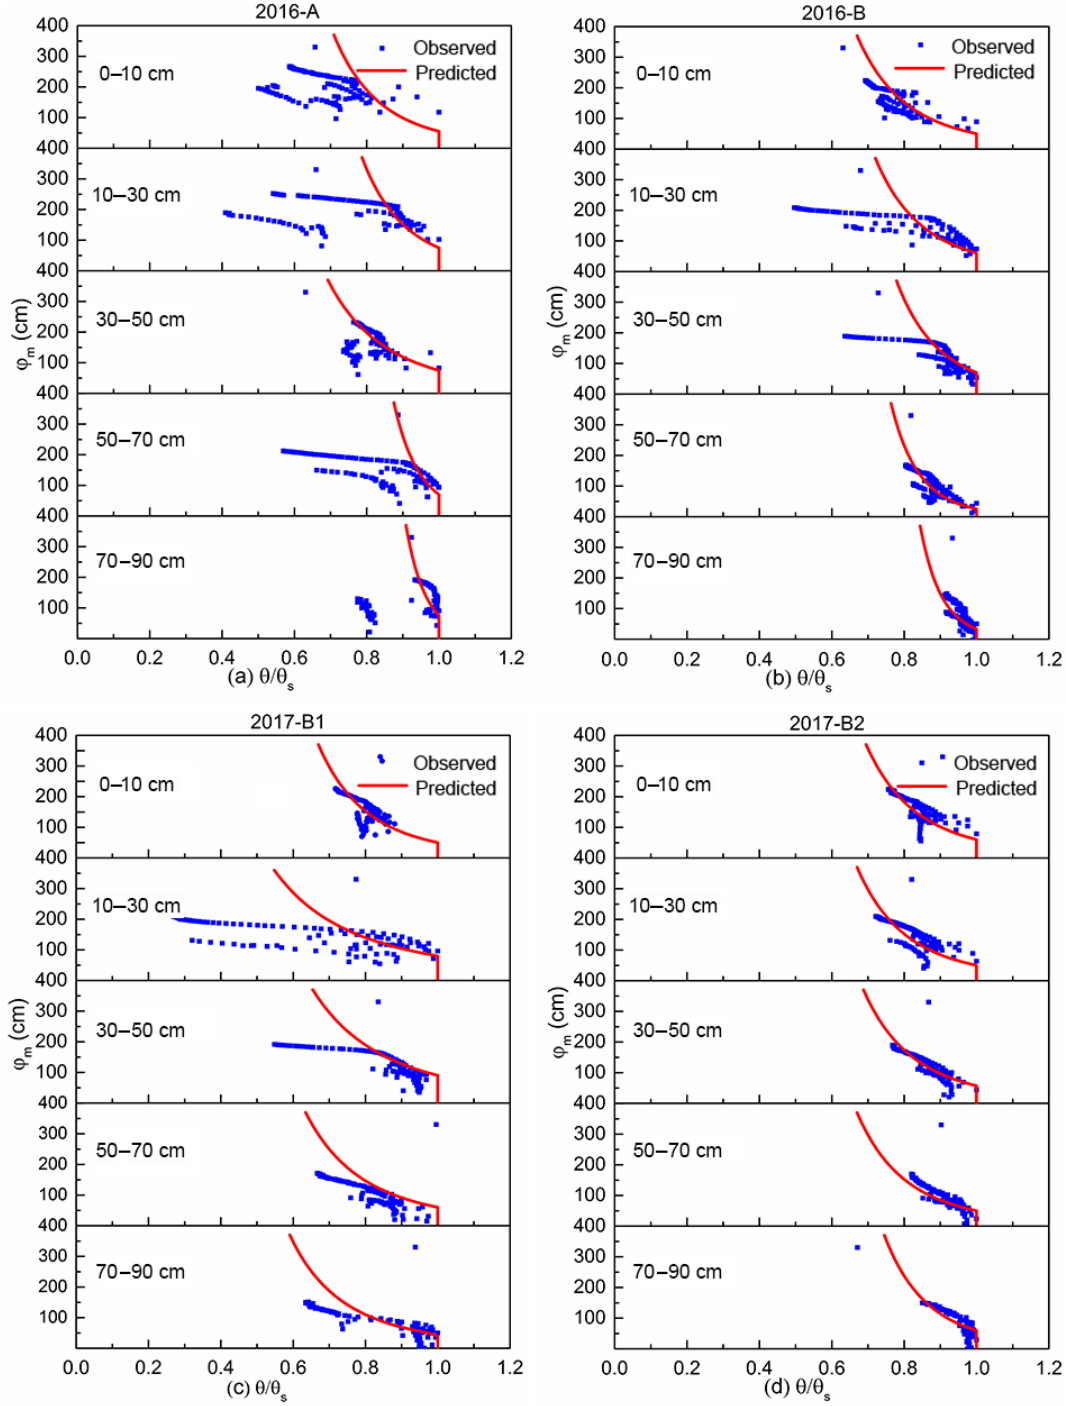
Figure 6. Soil moisture characteristic curve of the four experiment fields for the Fenzidi experimental fields. The red line is the fit with the Brooks–Corey